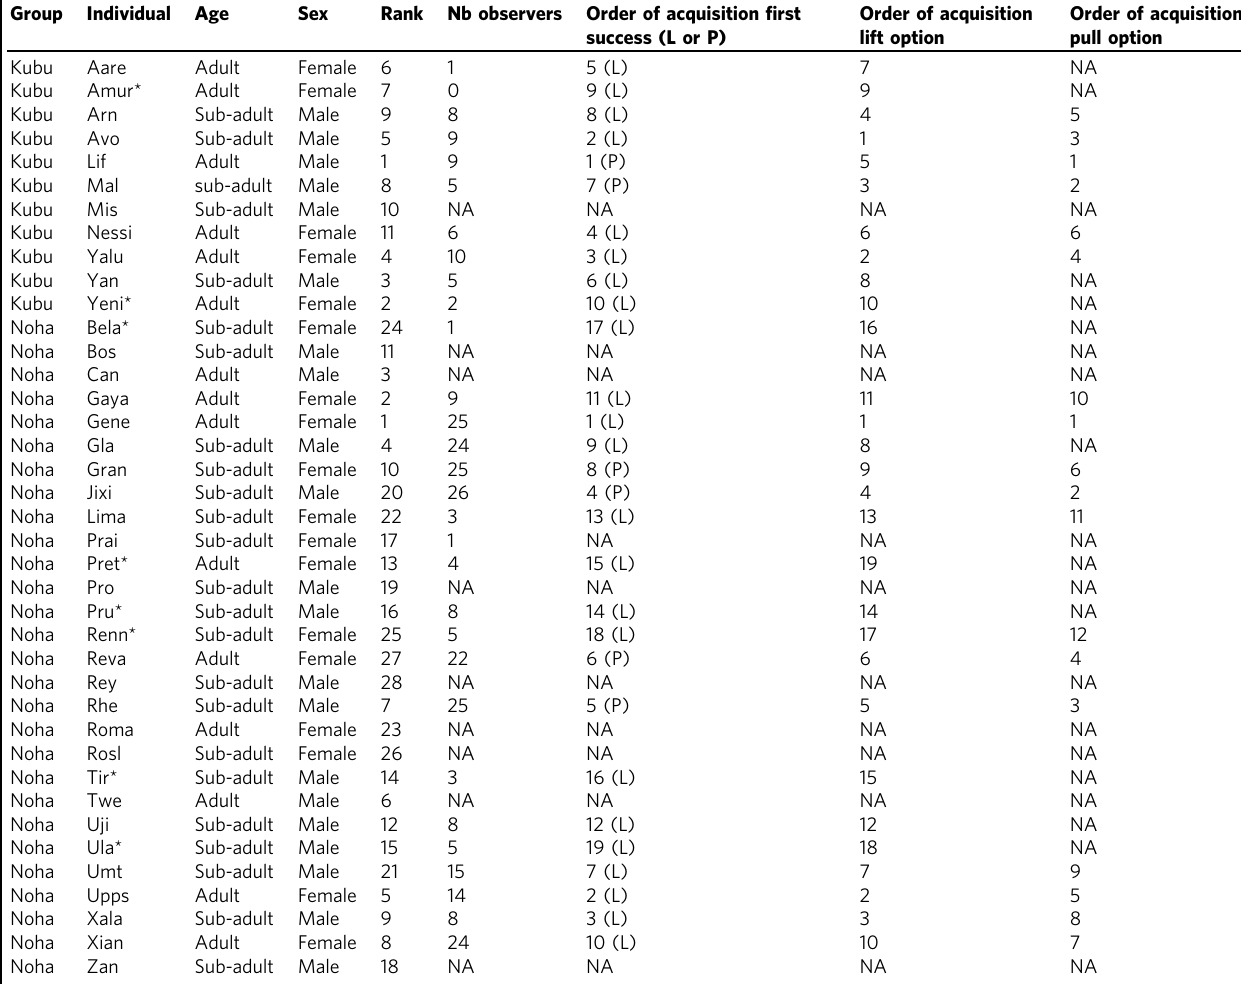
Table 1 Composition of the two study groups Noha (NH) and Kubu (KB). Group Individual